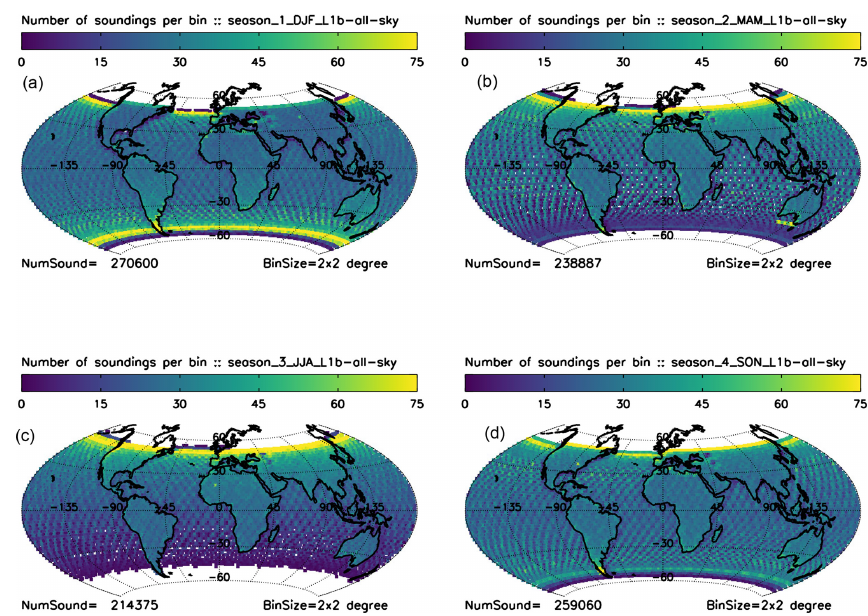
Figure 3. Seasonal L1b sounding density maps for 2 ◦ latitude by 2 ◦ longitude bins. (a) DJF, (b) MAM, (c) JJA, and (d) SON. Values should be inflated by 240 to reflect real expected sounding densities at the full spatial (eight footprints per frame) and temporal (3Hz) acquisition rates.